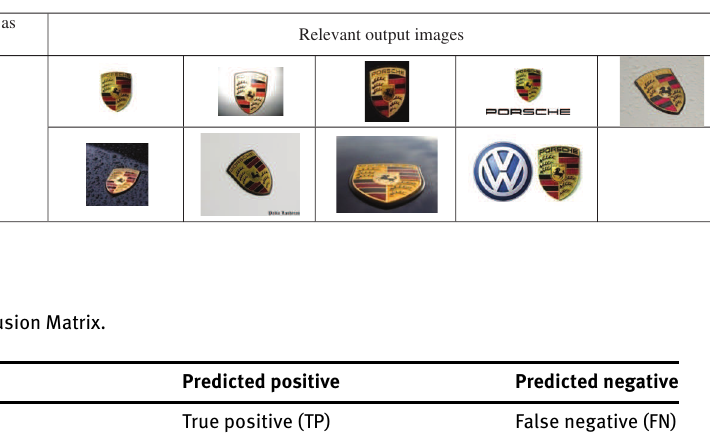
Table 4: Shape Similarity-Based Output Retrieved Images.